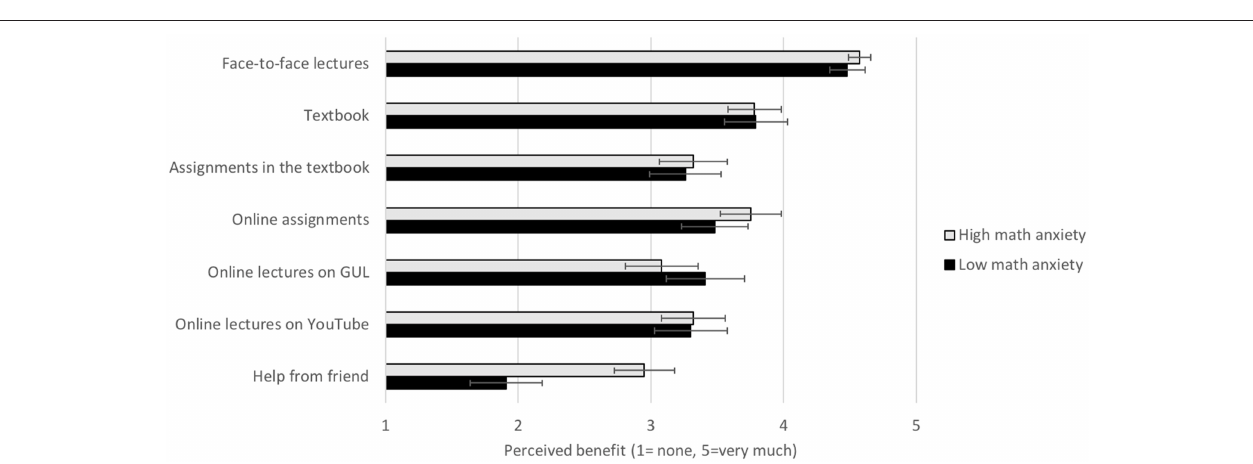
FIGURE 2 | The perceived benefit of teaching and learning methods by students high and low in Math anxiety ( n = 65).